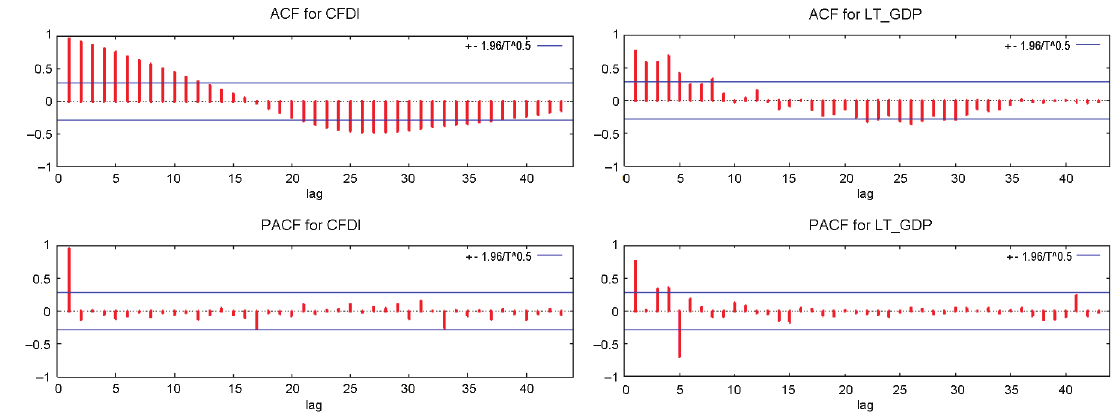
Fig. 7. Plotting the autocorrelation function (ACF) and partial autocorrelation function (PACF) for Lithuania’s CFDI and the construction’s contribution to GDP